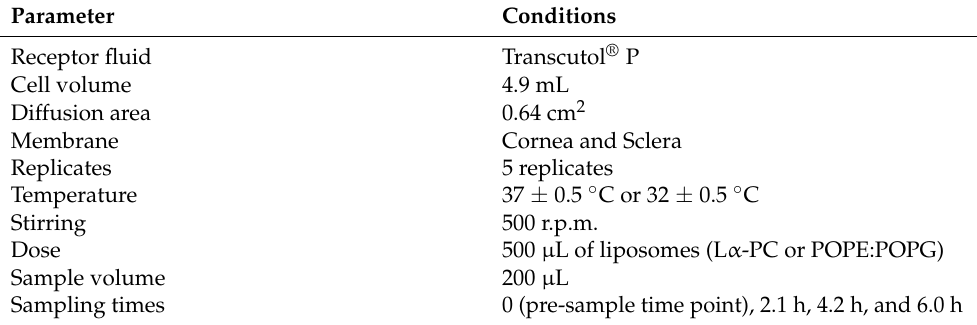
Table 2. Experimental conditions for the ex vivo permeation test.